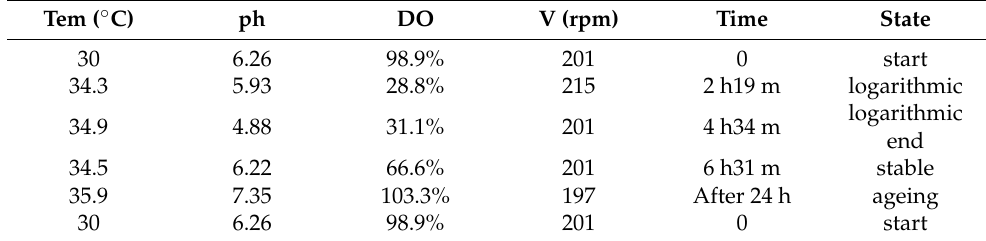
Table 1. Fermentation Conditions of